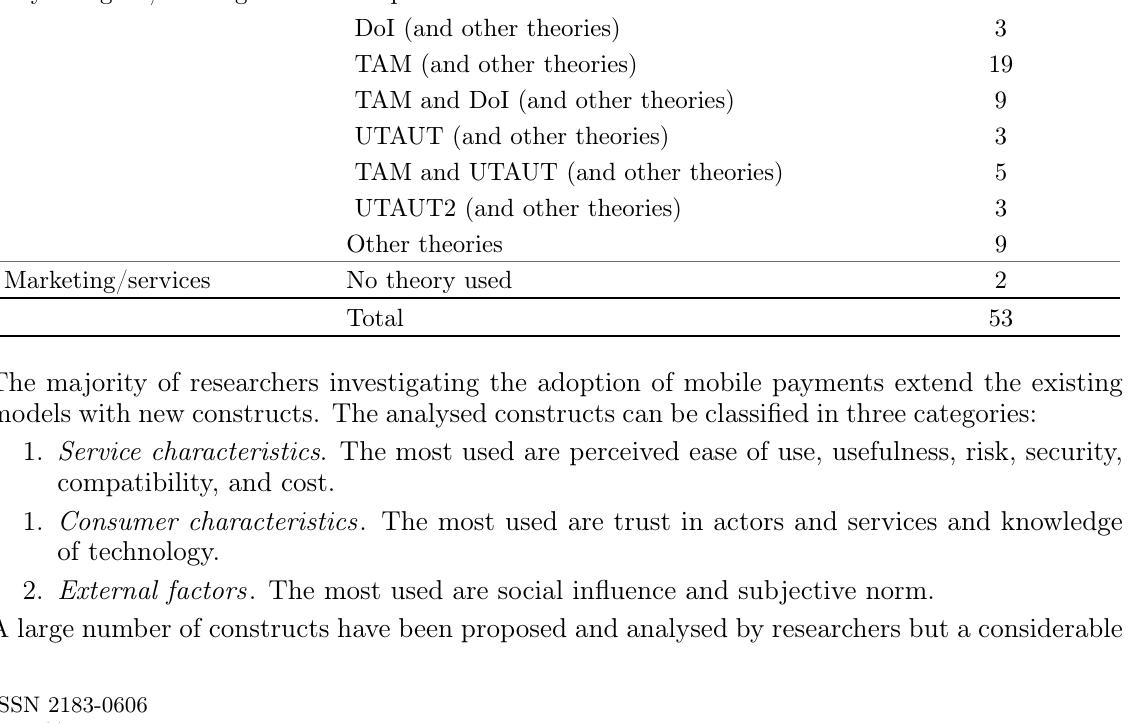
Table 13. Theoretical base used in research on customer adoption of mobile payments.